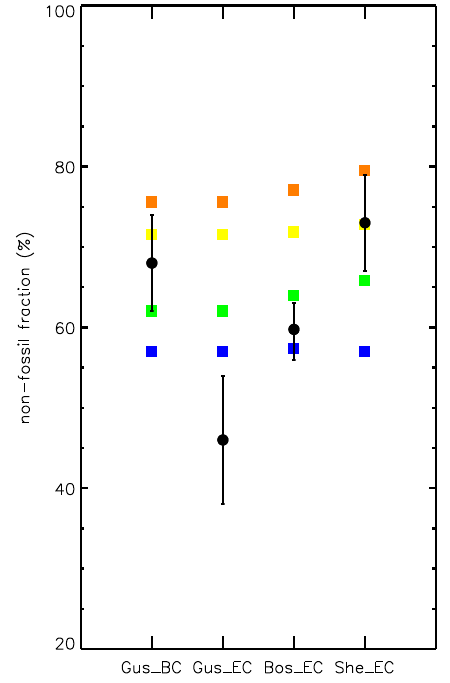
Figure 8. Comparison of simulated (squares) and observed (cir- cles, error bars show uncertainty range) contributions of non- fossil (residential biofuel and open biomass burning) sources to BC concentrations in Hanimaadhoo, Indian Ocean. Observations are from Gustafsson et al. (2009) (“Gus EC” (thermo-optical) and “Gus BC” (optical) for January–March), Bosch et al. (2014) (“Bos EC” (thermo-optical) for February–March), and Sheesley et al. (2012) (“She EC” (thermo-optical) for November–February). Model simulations are represented by squares: standard emissions (blue: res_base; green: res_monthly) and where residential car- bonaceous emissions have been doubled (yellow: res_ × 2; orange: res_monthly_ × 2). Simulated fractional contributions are averaged over the time of year that the observations were